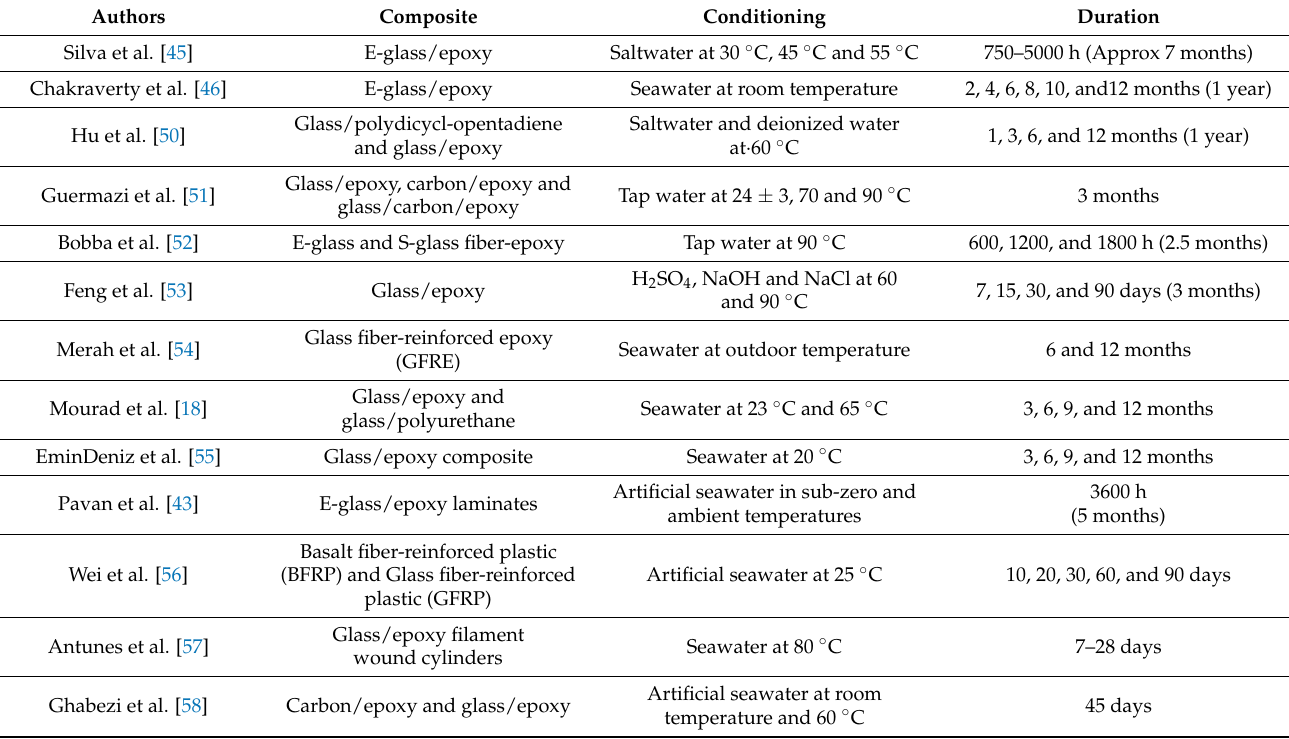
Table 1. FRP composite immersed at different environmental conditions.